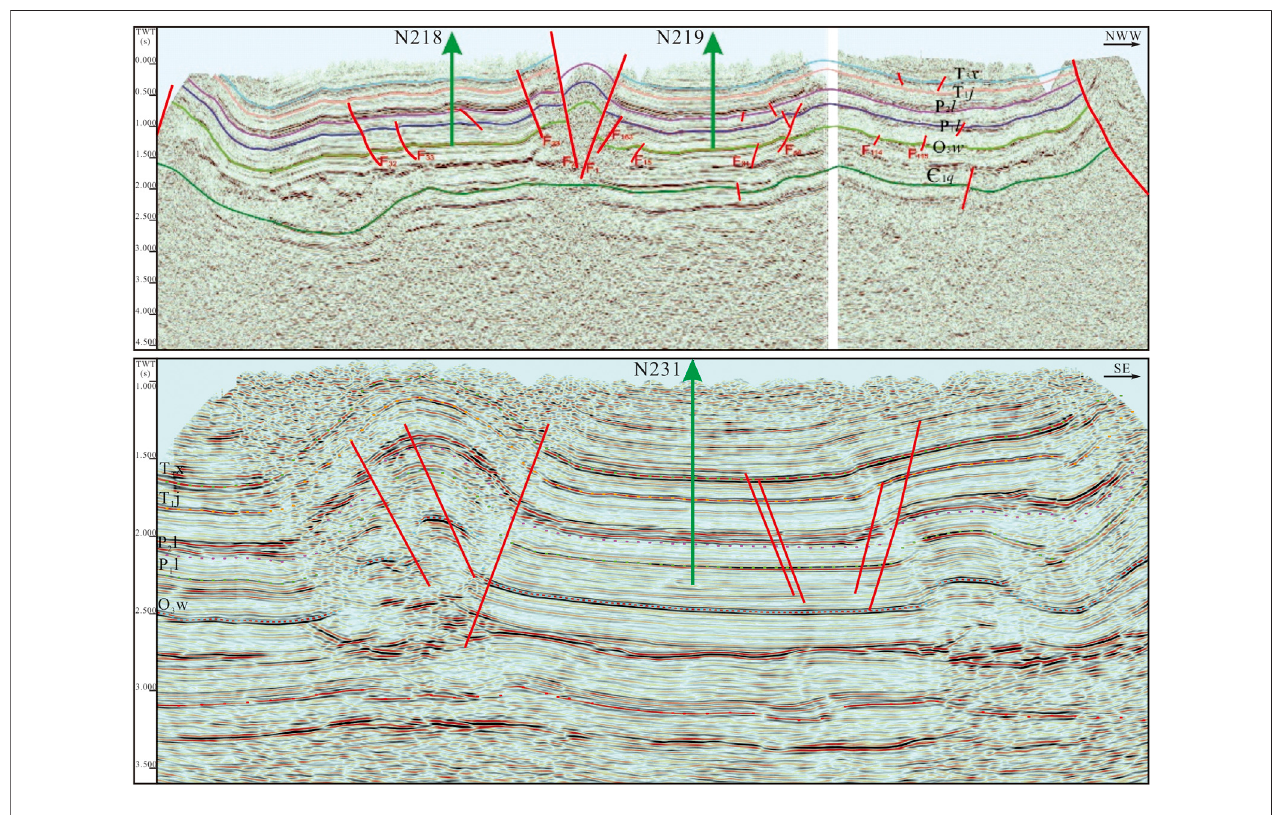
FIGURE 7 | Characteristics of the faults in seismic pro fi les.